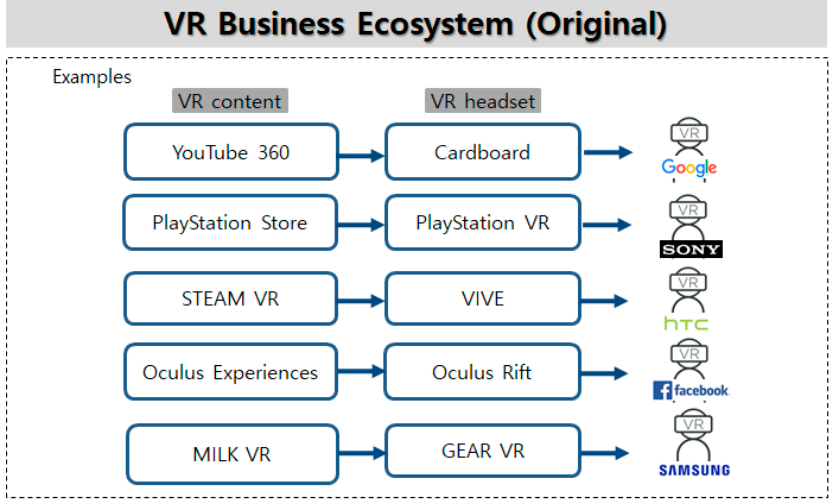
Figure 6. Original virtual reality (VR) business ecosystem.